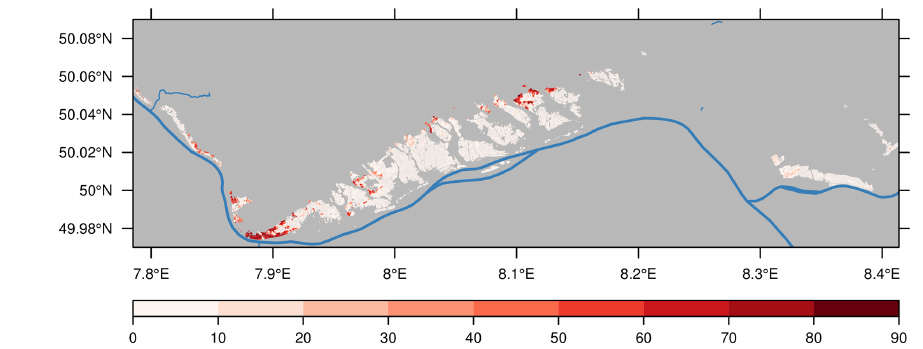
Figure 5. Number of simulated drought stress days per vineyard plot for the wine-growing region Rheingau, Germany, during the 2018 veg- etation period (1 May–30 September). Calculations were conducted with a water balance model based on data from weather stations and a digital soil map on the assumption of alternating soil cultivation (one row bare soil, one row cover crop).